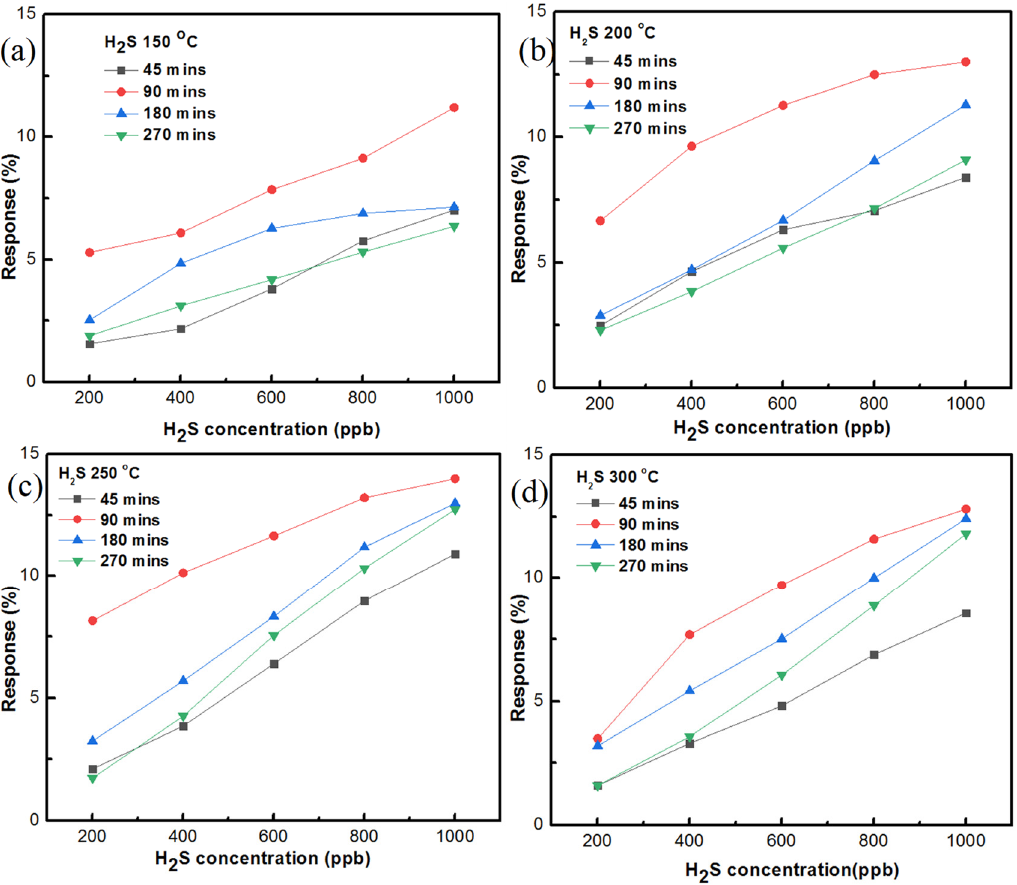
Figure 12. Summary of the H 2 S gas-sensing responses of ZnO nanostructure prepared on AZO and 40 nm Al at different temperatures with growth times of ( a ) 45 min, ( b ) 90 min, ( c ) 180 min, ( d ) 270 min.